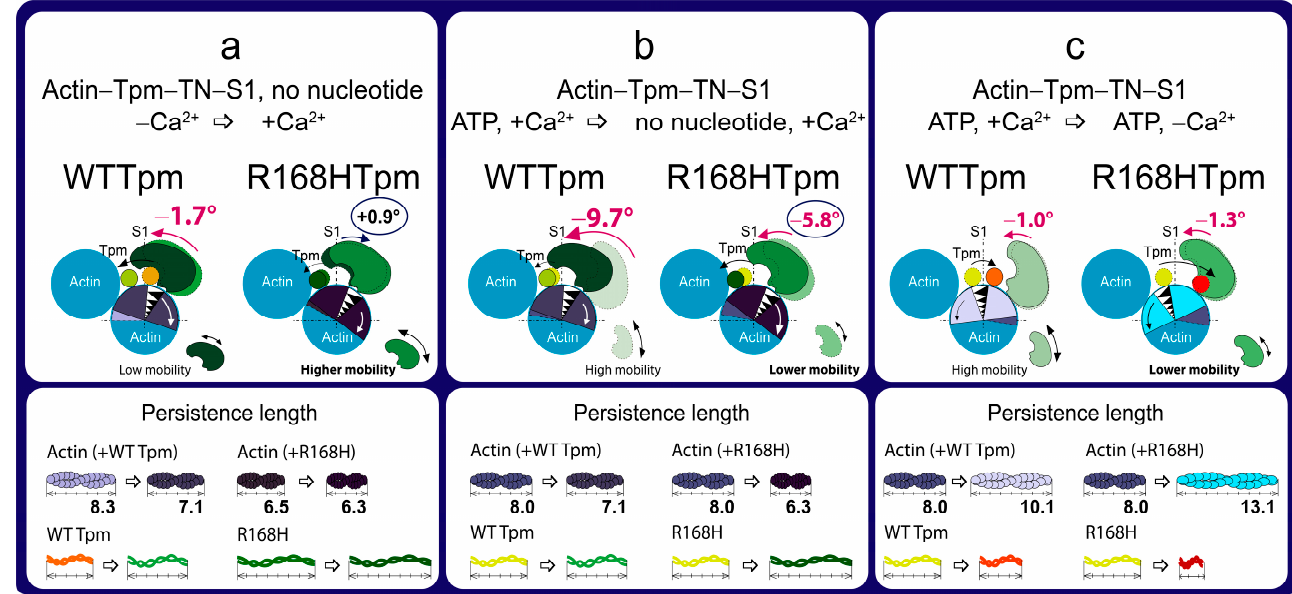
Figure 3. The scheme explains the effect of the R168H mutation on the spatial rearrangement of the myosin head (S1), the position of tropomyosin (Tpm), the angular orientation of actin monomer, and the persistence lengths of the Tpm strands and actin filaments. Three different transitions are shown, influenced by ( a ) an increase in Ca 2+ concentration in the absence of nucleotides, ( b ) a weak-to-strong transition, and ( c ) a decrease in Ca 2+ concentration in the presence of ATP. Information was obtained from the calculation of the value of Φ E —the orientation angle of the emission dipoles of the fluorescent probes bound to S1, and the value of ε —the bending stiffness (shown here as the alterations in the persistence lengths of the Tpm strands and actin filaments). The N parameter was used to judge the increase or decrease in the mobility of myosin heads (shown by big and small double-edged arrows). In all states, except for the high Ca 2+ in the absence of the nucleotide, the conformation of S1 in the presence of R168HTpm is characteristic of the formation of strong binding of myosin to actin. The mutation reduces the persistence length of actin in the absence of the nucleotide and significantly increases it in the presence of ATP at low Ca 2+ . The persistence length of Tpm changes conversely. The R168H substitution prevents the activation of the protein complex in response to an increase in the Ca 2+ concentration. Designations: numbers show changes in the value of Φ E for S1-AEDANS between states (red numbers are characteristic of an increase in the population of strong-binding myosin heads). Arrows show directions of tilt of the myosin head and rotation of actin monomer relative to the fiber axis, as well as displacement of tropomyosin over actin. Different localizations of Tpm and conformational states of actin and their corresponding persistence lengths are depicted by different colors.